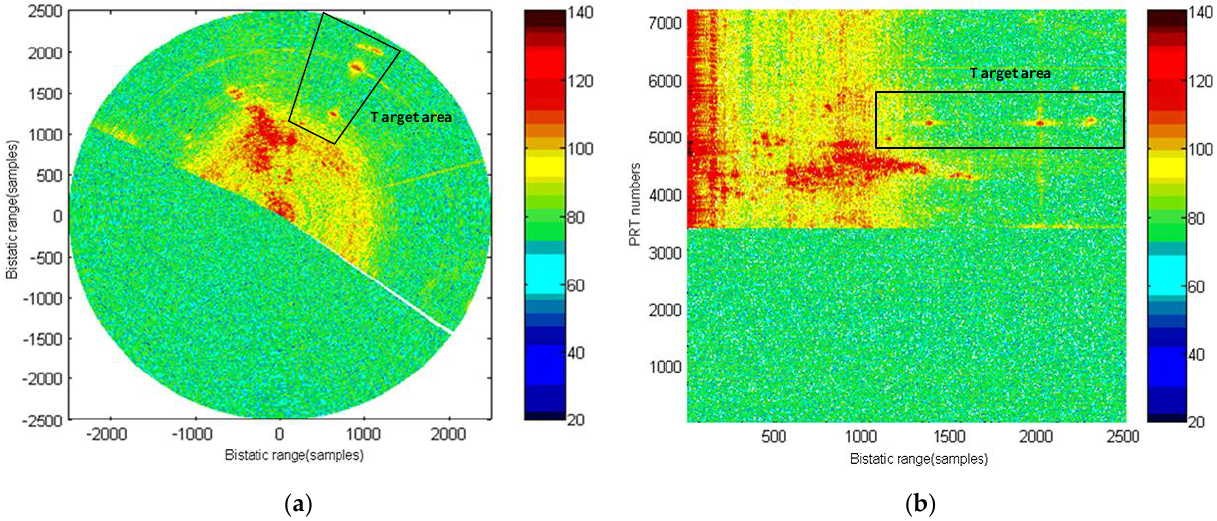
Figure 20. Original HBR map for maritime moving target detection: ( a ) PPI display; ( b ) Range-azimuth display.